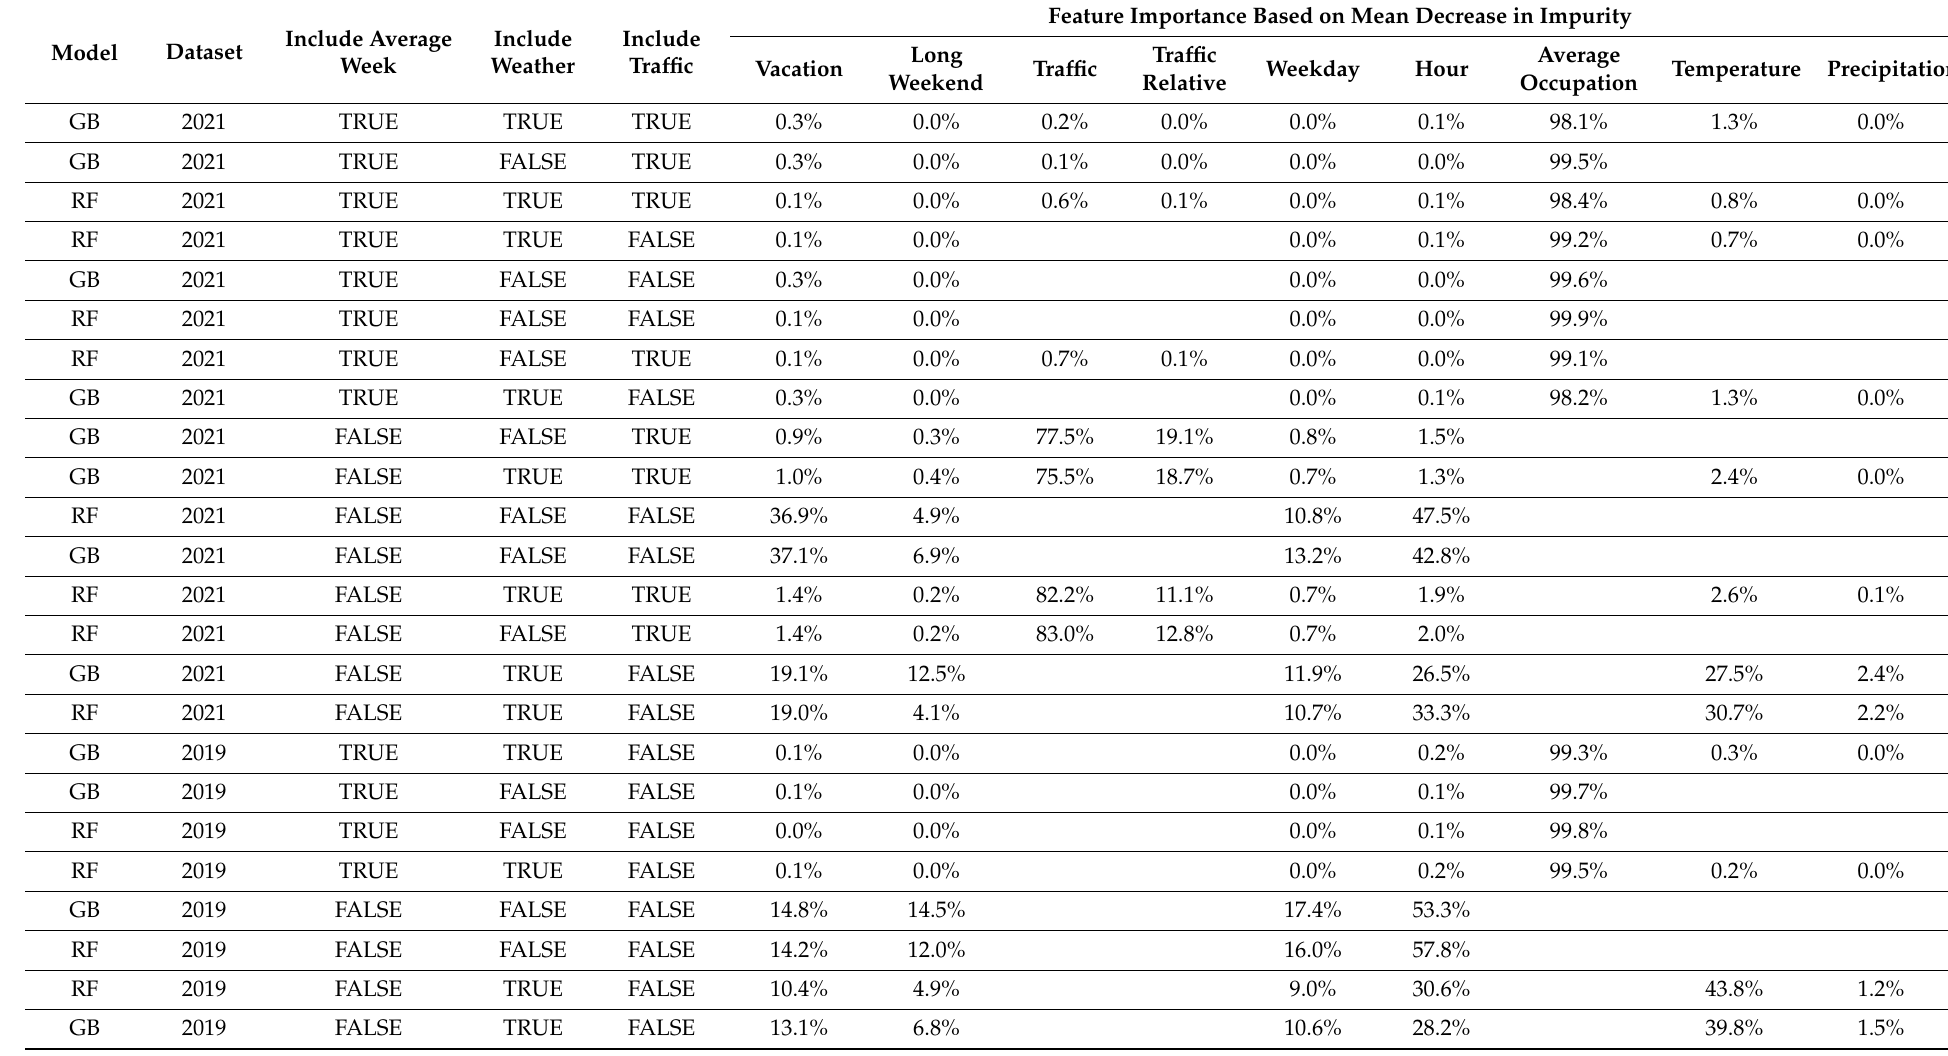
Table A1. Feature importance based on mean decrease in impurity of selected models, sorted by dataset first and then by MCC (i.e., same as in Table 4).